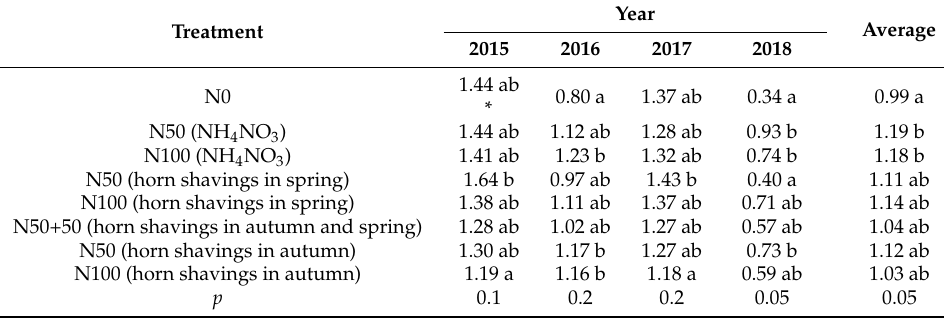
Table 5. Fertiliser effect on Ligol apple tree yield efficiency (kg/cm 2 TCSA).